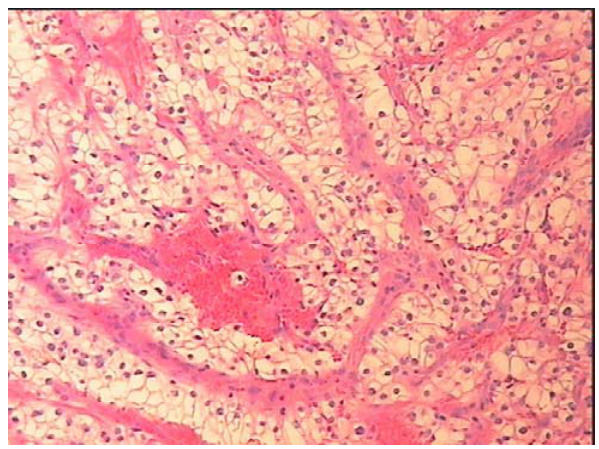
FIGURE 1 . Microscopic examination of skin lesion at high power suggests clear cell carcinoma.